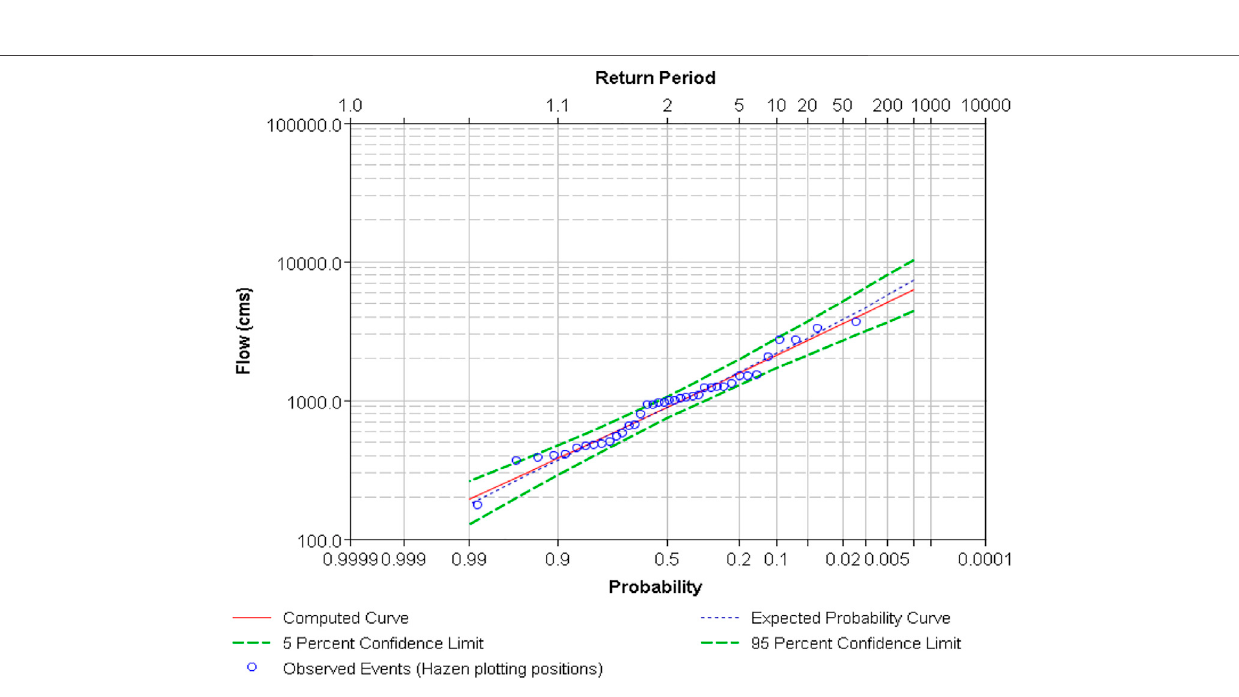
FIGURE 4 | Flood frequency and probability at Son Diem hydrological